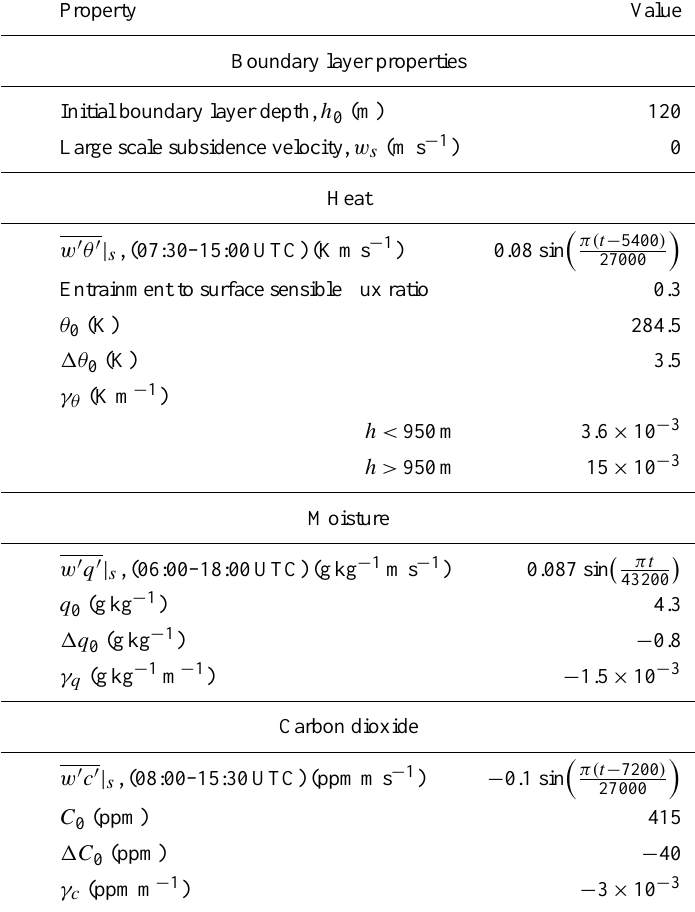
Table 1. Initial and prescribed values used for the mixed layer model based on the observations taken at Cabauw (The Netherlands) on 25 September 2003. The value of γ θ is prescribed in the mixed-layer model following van Heerwaarden et al. (2010). The conversion factor to transform mixing ratio to mass concentration for CO 2 at T = 288K is 1ppm=1.862mgm − 3